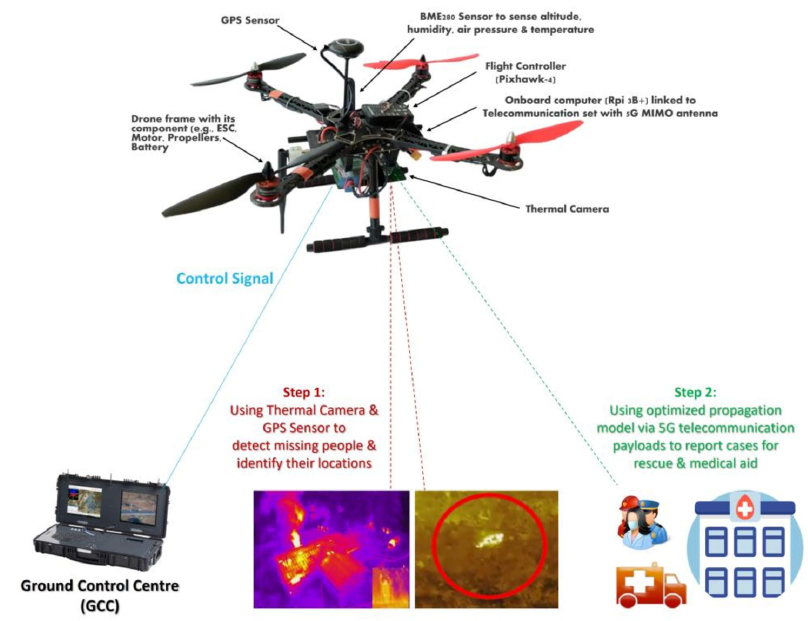
Figure 2. Proposed structure of a drone for use in search-and-rescue operations.